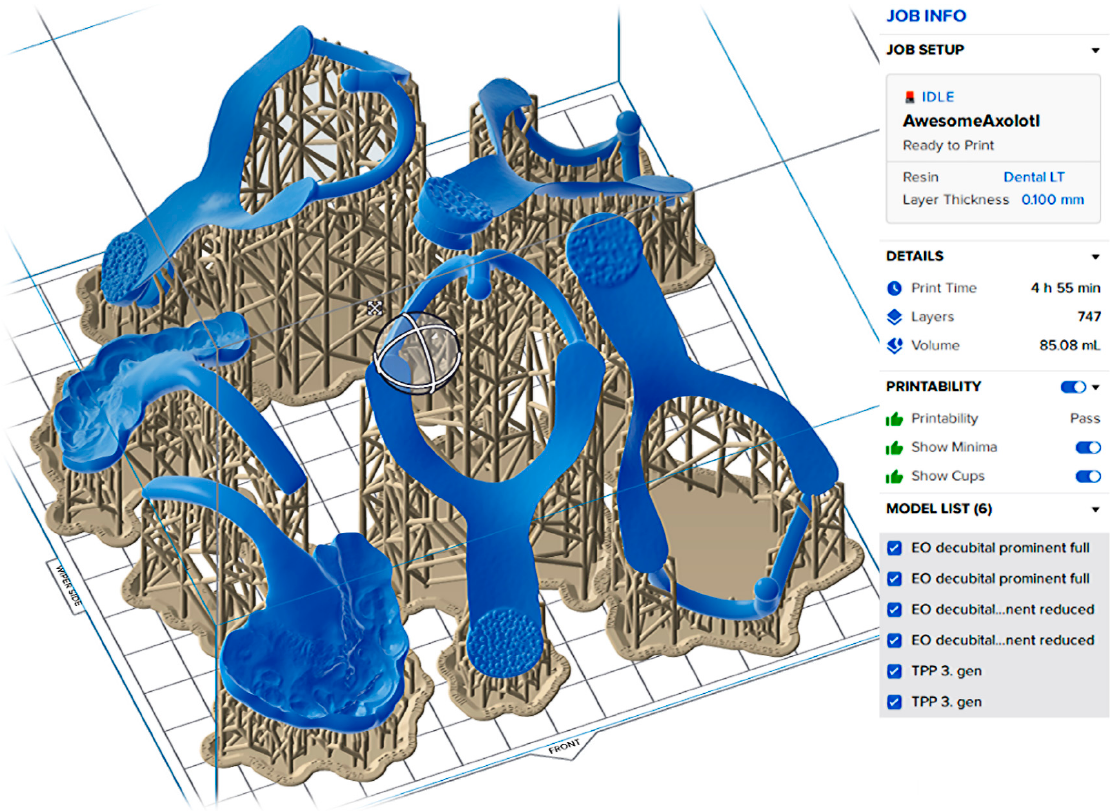
Figure A1. The setting of the objects for SLA 3D printing with Dental LT Clear V2 (Formlabs) on 3D printer Form 2, Formlabs, Somerville, MA, USA) is important. Limitation of 0.1 mm Layer Thickness can result in additive manufacturing failure. Faces where the surface is planned to be of the highest accuracy or polished shall not be burdened with support that needs to be cleared later.